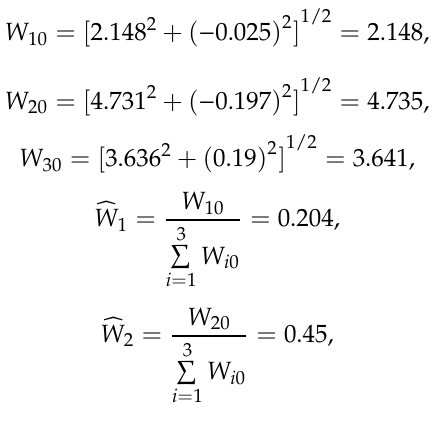
Table 17. The modified weights of evaluation criteria Main Criteria